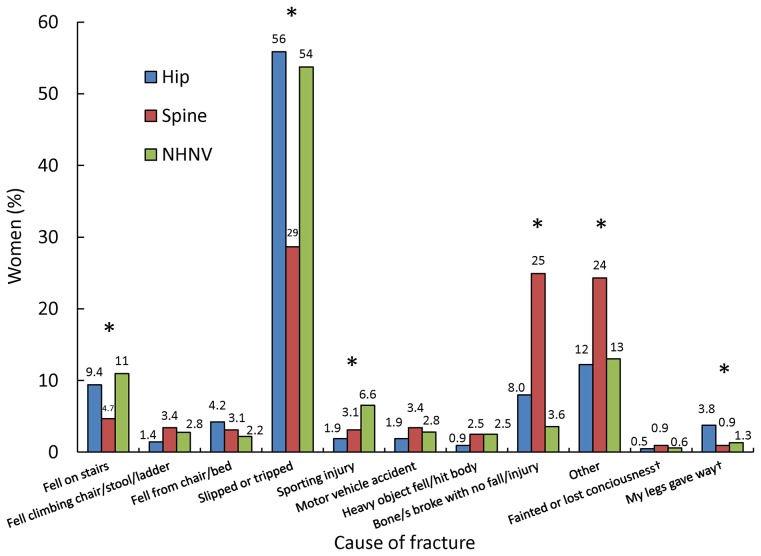
Cause of fracture by fracture type.Significant differences for each cause between fracture types (P<0.05) are denoted by an asterisk. Dagger denotes response only available on year 3 survey. NHNV, non-hip, non-vertebral.